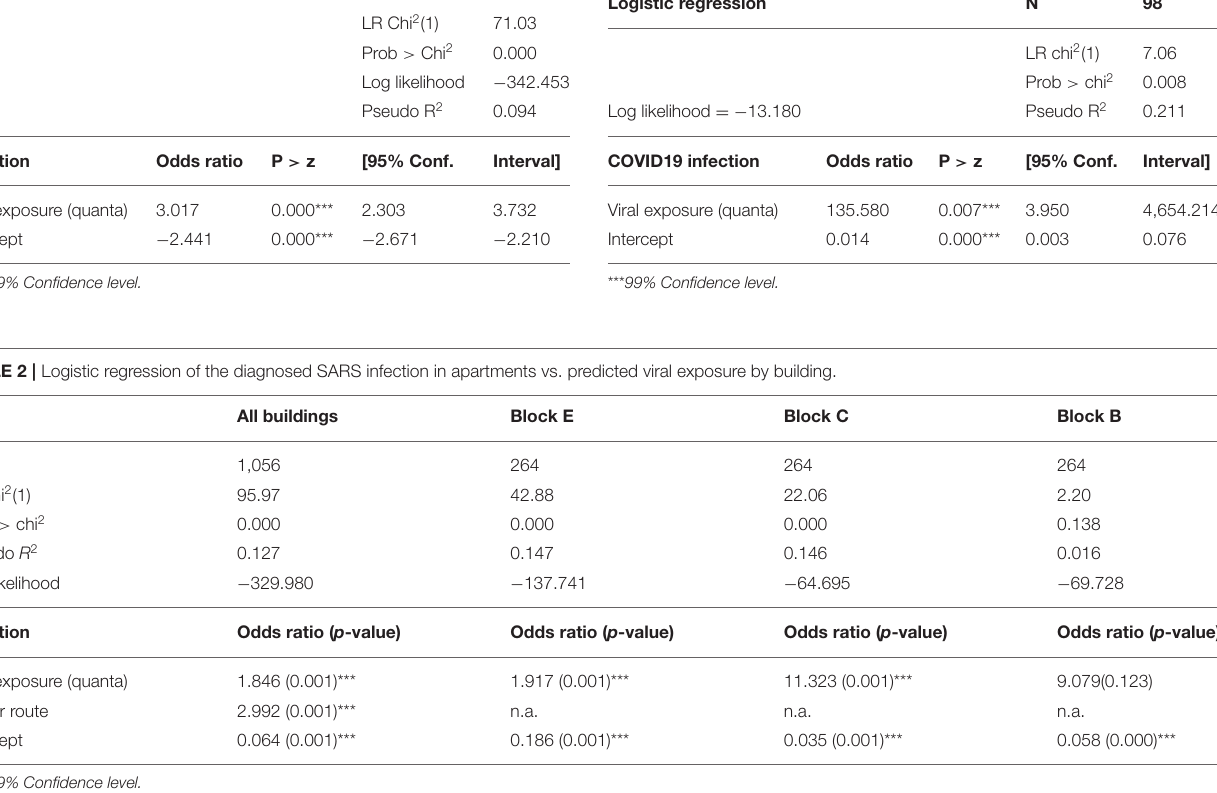
TABLE 3 | Regressing COVID-19 infection on the predicted viral exposure in the Luk Chuen House. Logistic regression